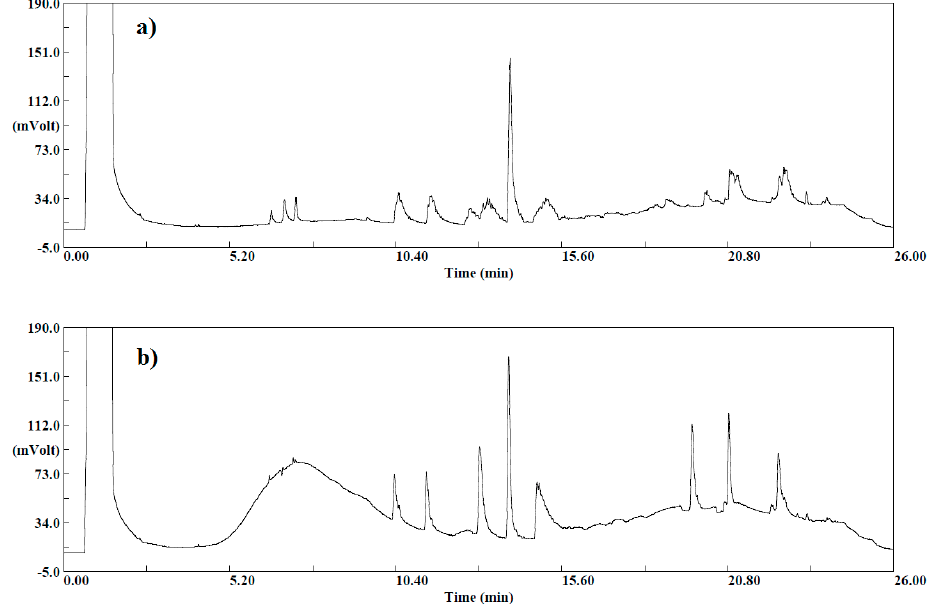
Figure 3. Chromatograms obtained for the extracts from: ( a ) 5 mL (1:10) of sample solution and ( b ) 5 g of the original sample by using QuEChERS-GC-ECD.